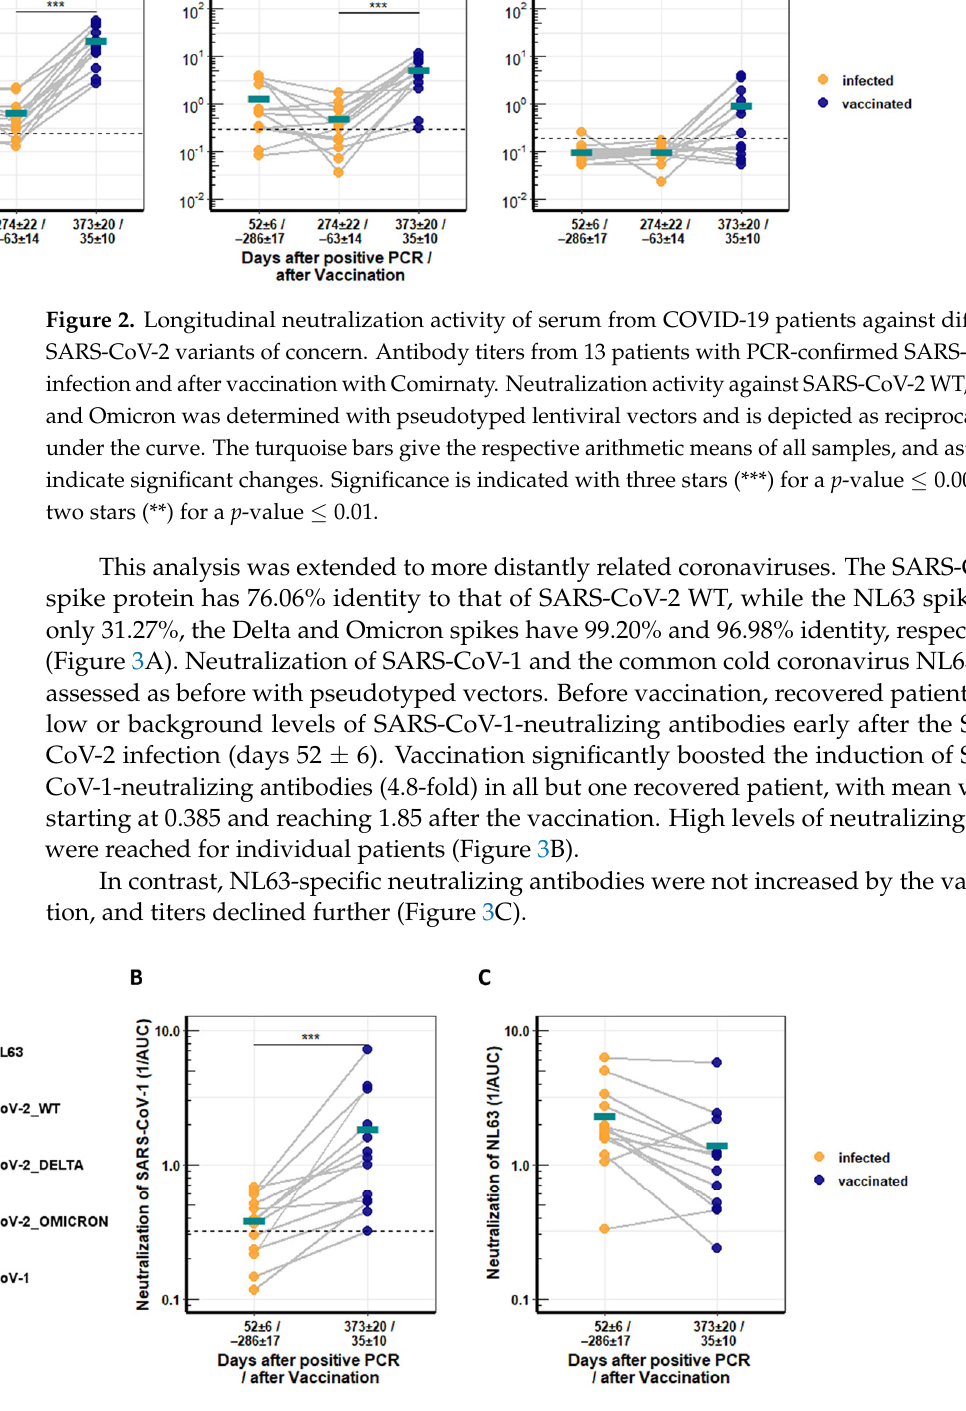
Figure 3. Longitudinal neutralization activity from serum of COVID ‐ 19 patients against distantly related CoVs. ( A ) Neighbor ‐ joining tree based on receptor binding domains (RBDs) of different coronaviruses. ( B ) Neutralization activity of COVID ‐ 19 convalescent serum against SARS ‐ CoV ‐ 1 before and after Comirnaty vaccination. ( C ) Neutralization activity of COVID ‐ 19 convalescents serum against NL63 before and after Comirnaty vaccination. Serum neutralization was determined with pseudotyped lentiviral vector particles. Asterisks indicate significance levels, and turquoise bars denote respective mean values.